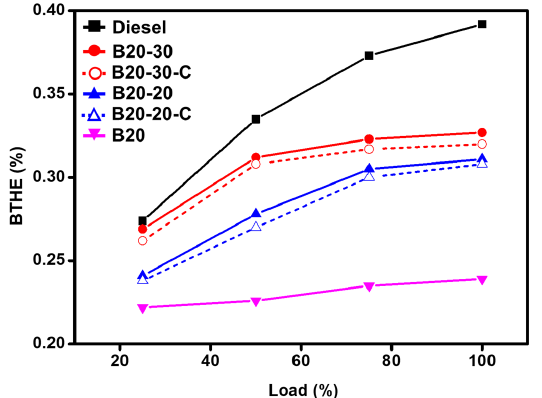
Figure 6. Comparative graphical illustration of brake thermal efficiency (BTHE) from diesel and blends vs. load (%) (with ZnO-GS and ZnO-C). B20 is D-COME, i.e., discarded cooking oil methyl ester, which is blended with 20% commercial diesel; B20-20 is the blend of B20 with 20 mg of ZnO-GS/C; B20-30 is the blend of B20 with 30 mg of ZnO-GS/C.